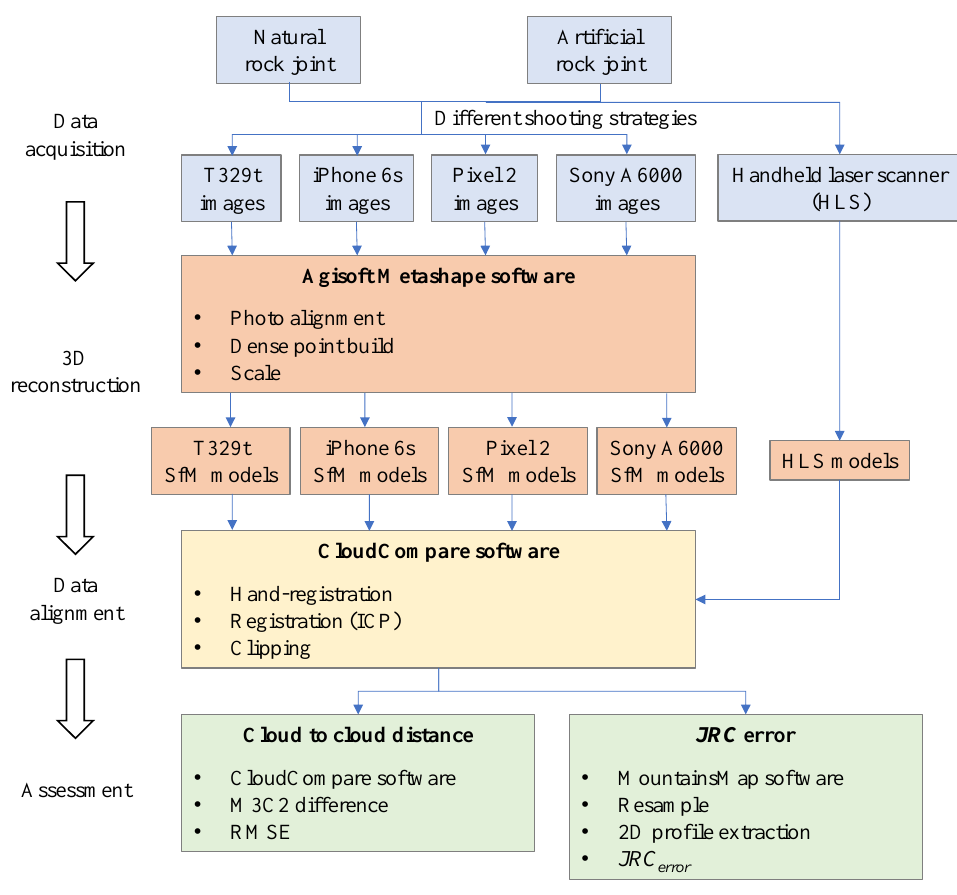
Figure 1. Overall workflow of the methodology.